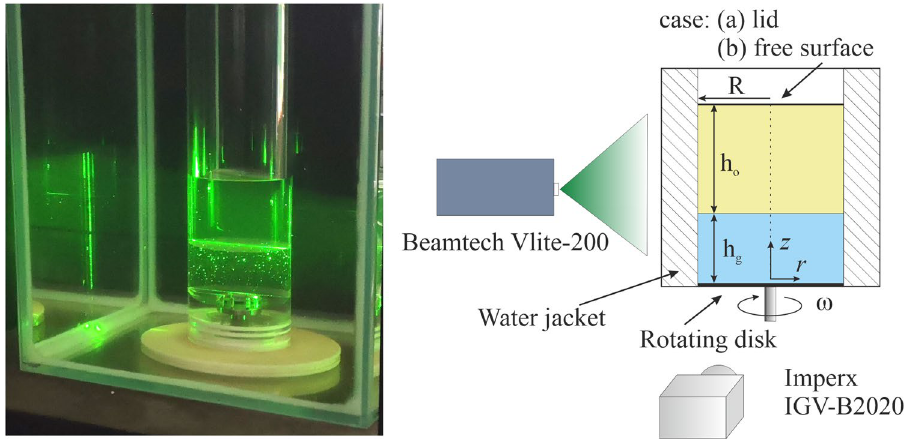
Figure 1. Photo of set-up (left), experimental setup scheme (right), R = 73 mm, h = 2.5 R , h g = R , and h o = 1.5 R